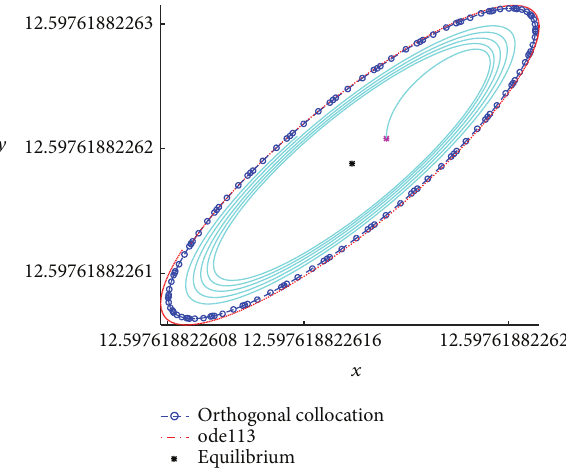
Figure 5: Codimension 2 (see (48)), 𝑠 = −1 , Region 𝑅 1 . Stable cycle and behavior of inner orbits for (𝜎,𝑐,𝑏,𝑏 2 ) = (30,4.1861, 5.29,−1) ( 𝑏 𝑐𝑟 = 6.43618 ) (pink marker marks the beginning). Unstable equilibrium (black marker): (12.5976, 12.5976, 30) . ode113: Adams- Bashforth-Moulton PECE solver of orders 1 to 12 (Matlab).